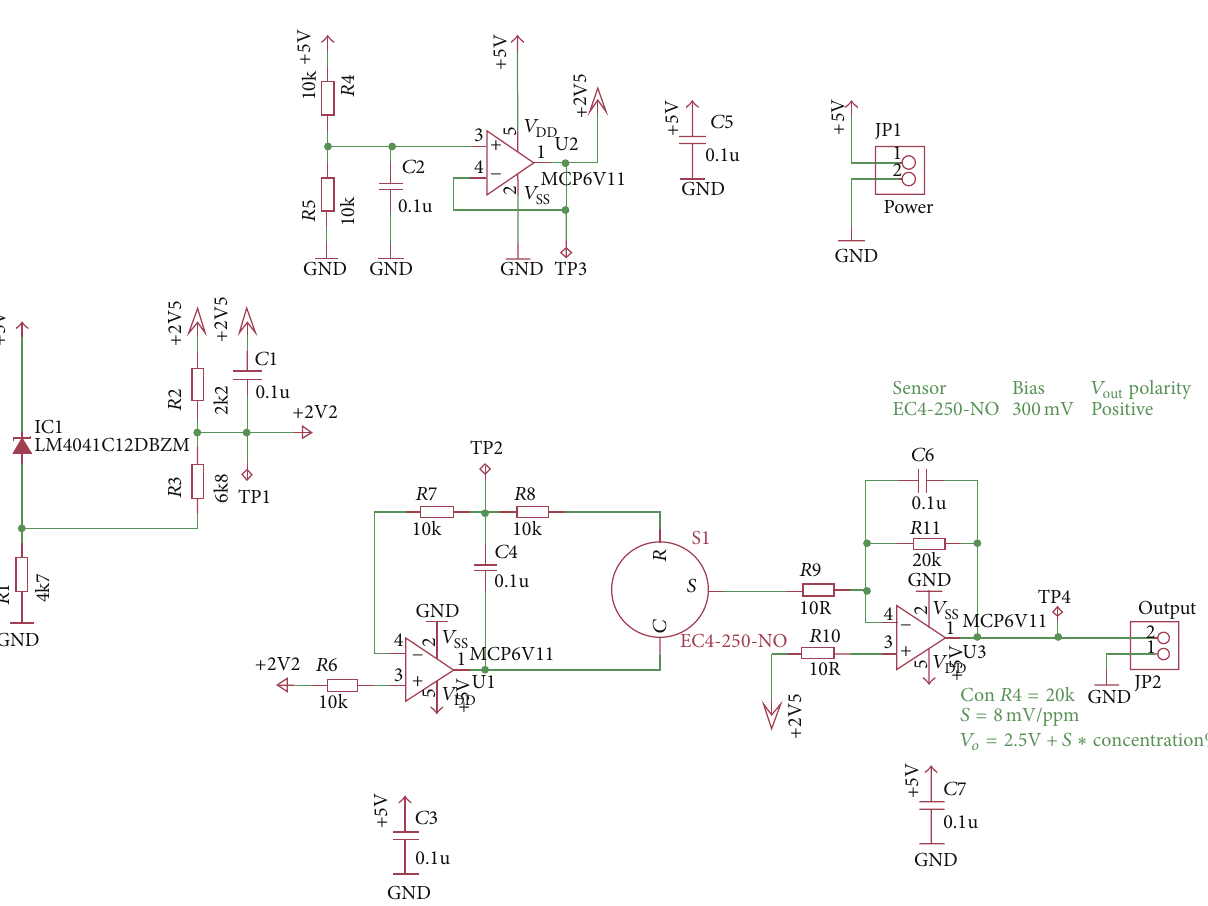
Figure 6: Circuit designed for NO signal